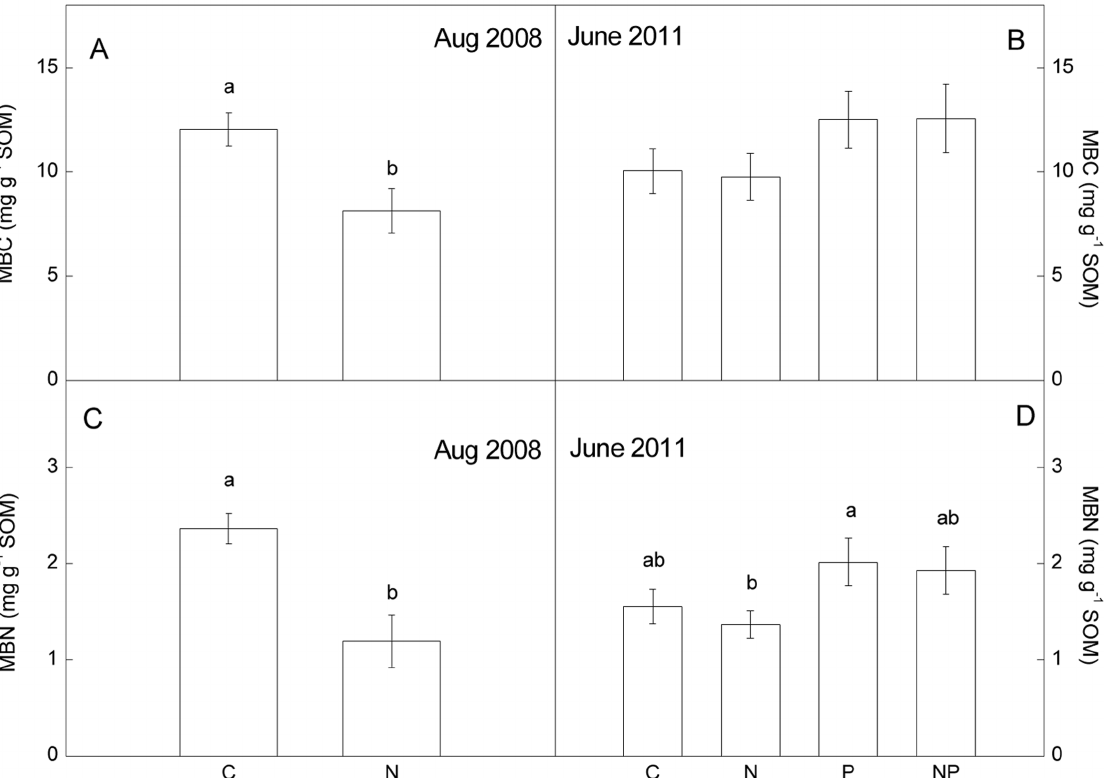
Figure 2. Microbial biomass in soils after nitrogen and phosphorus addition. Data from Aug. 2008 and June 2011. MBC: microbial biomass carbon; MBN: microbial biomass nitrogen. C: control, N: nitrogen addition, P: phosphorus addition, NP: nitrogen and phosphorus addition. Significant differences (p , 0.05) among treatments are indicated by different letters. Error bars show SE (n=5).